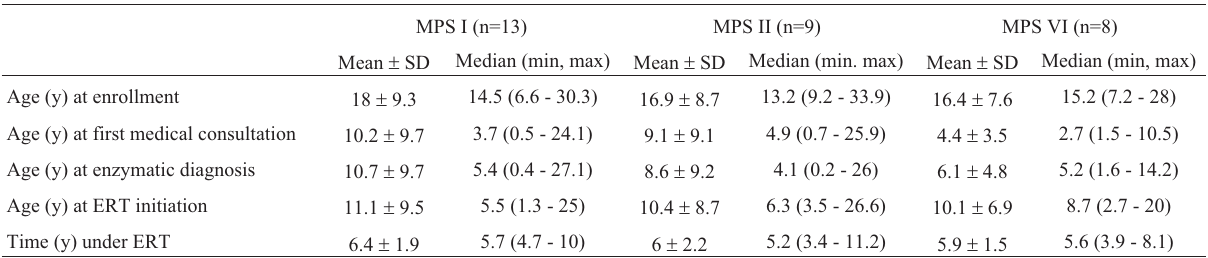
Table 2. The difference in GPx, GSHt, and GSH/GSSG